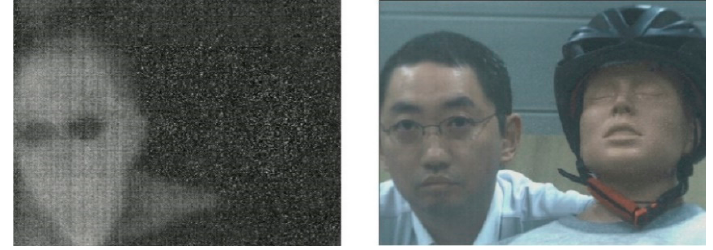
Figure 10. Thermal and visible images of a human and doll.